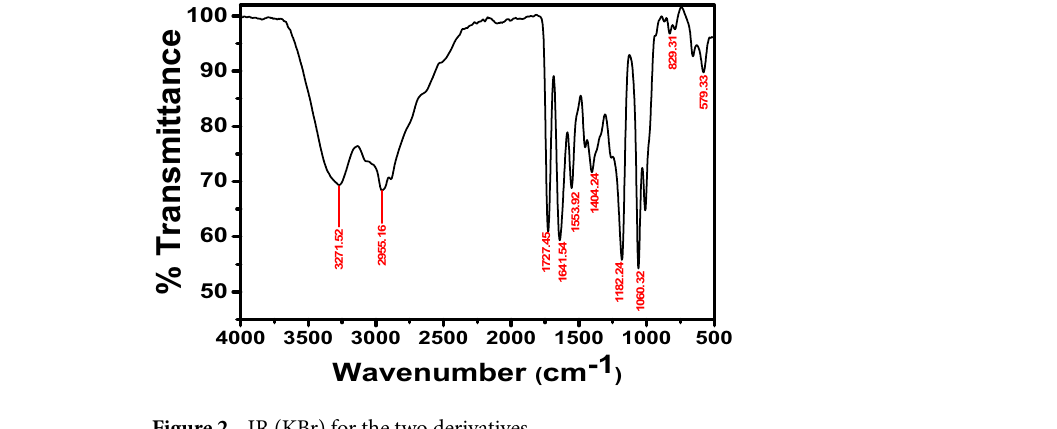
Figure 2. IR (KBr) for the two